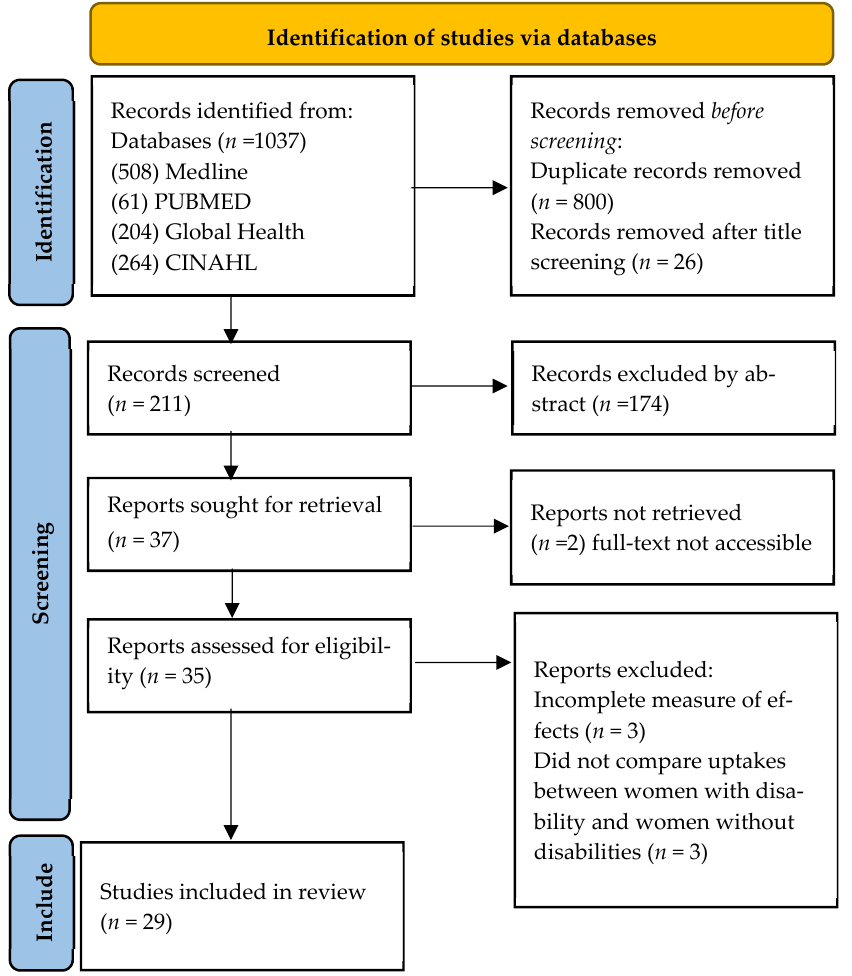
Figure 1. PRISMA flow chart of search results.